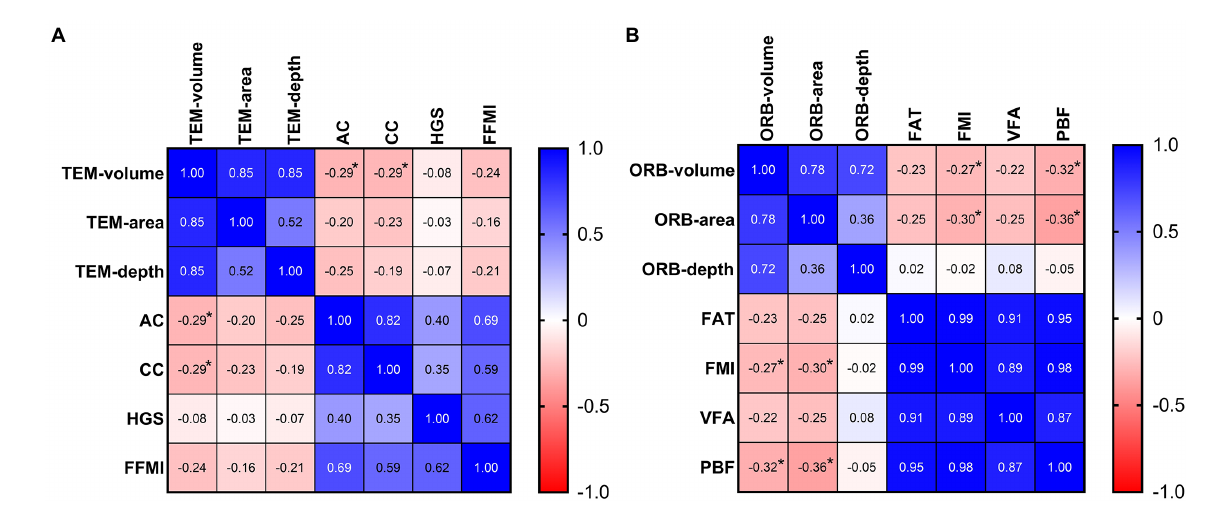
FIGURE 2 The correlation heatmaps between depression index and malnutrition phenotype. (A) The negative correlation between the temporal depression volume and muscle mass phenotype (AC and CC). (B) The negative correlation between the periorbital depression index (volume and surface area) and fat mass phenotype (FMI and PBF). AC, arm circumference; CC, calf circumference; FAT, fat mass; FFMI, fat-free mass index; FMI, fat mass index; HGS, hand grip strength; ORB, periorbital region; PBF, percent body fat; TEM, temporal region; VFA, visceral fat mass. Spearman correlation analysis: * p <